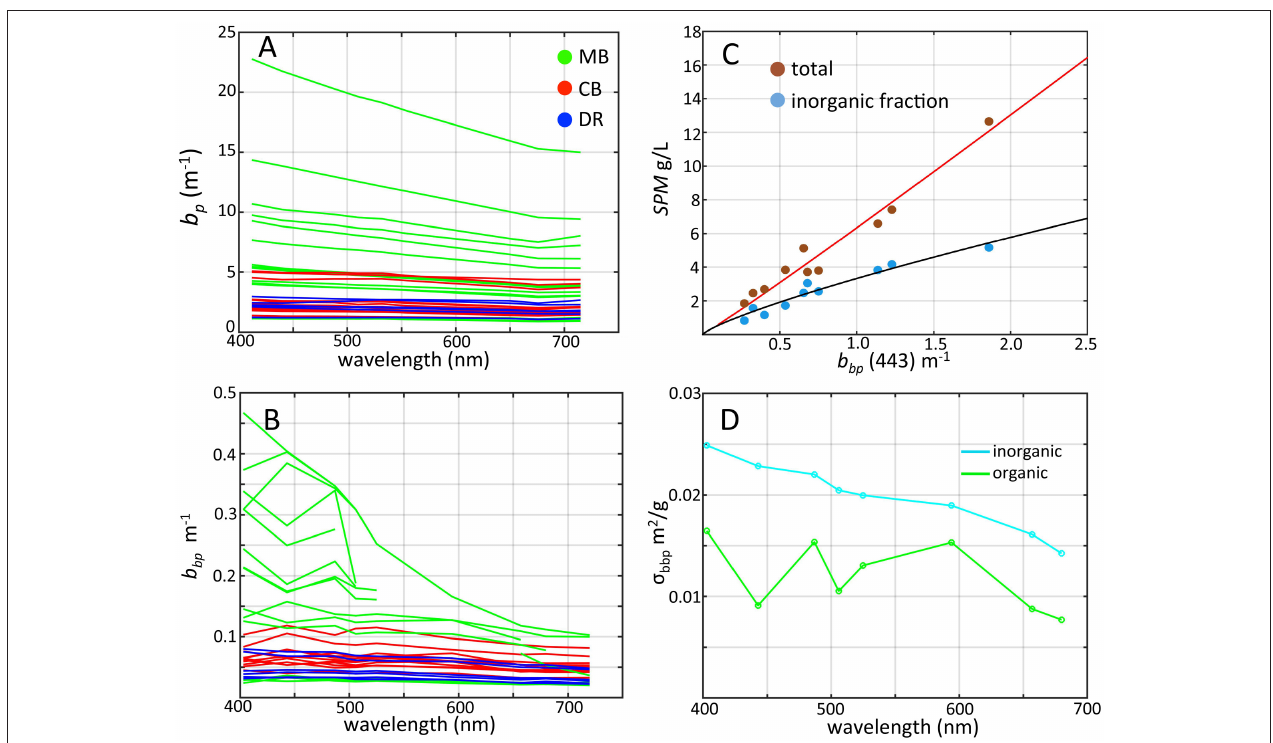
FIGURE 6 | Scattering properties of western Lake Erie as determined from WET Labs bb9 measurements colored by region. (A) Spectral particle scattering b p colored by region; (B) Particle backscattering at 443 nm colored by region; (C) SPM vs. particle scattering ratio at 443 nm (log scale) with nonlinear fit; (D) Mass-specific backscatter cross-section ( σ bbp ) for inorganic (light blue) and organic (green) particle